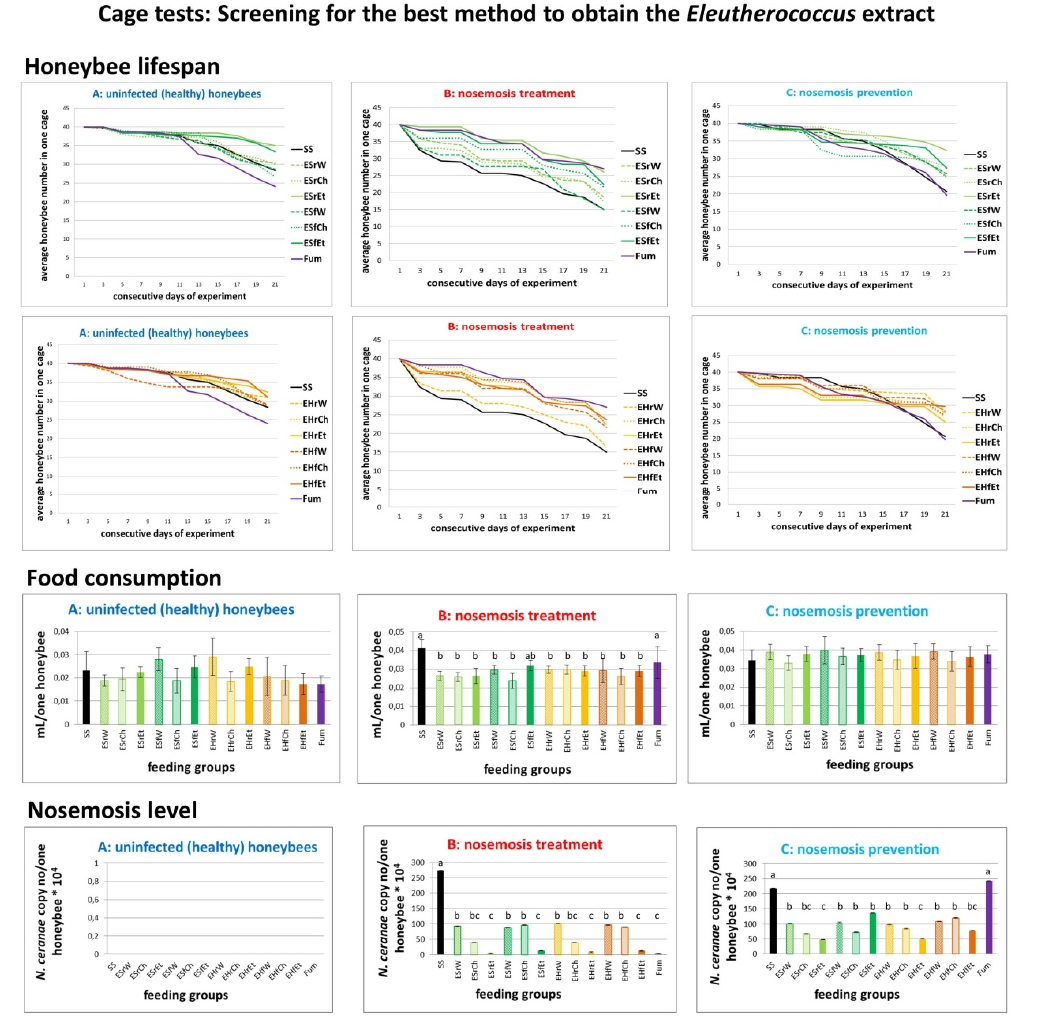
Figure 2. Results of cage tests: Screening for the best method of obtaining the Eleutherococcus extract. Data illustrated honeybee lifespan, food consumption and levels of nosemosis in all three variants of experiments conducted, i.e., ( A ) uninfected honeybees, ( B ) treatment of nosemosis and ( C ) prevention of nosemosis were compared. Lowercase letters (a,b,c) indicate significant differences between the group fed pure sucrose syrup without extracts (SS) and the groups fed with additions of extracts (at least p ≤ 0.05 for the honeybee lifespan, p ≤ 0.01 for food consumption and p ≤ 0.005 for level of nosemosis) (ANOVA, Tukey test). Error bars denote a confidence interval (CI). Laboratory extracts of E. senticosus (ES) and E . henryi (EH) were obtained using three different methods (water, W, chloroform, Ch, and ethanol, Et, extraction) from these plants’ roots and fruits (Table 2). 14 feeding groups (acronyms are defined in Supplementary Materials Table S2), i.e., (1) SS (control, pure sucrose syrup), (2) ESrW, (3) ESrCh, (4) ESrEt, (5) ESfW, (6) ESfCh, (7) ESfEt, (8) EHrW, (9) EHrCh, (10) EHrEt, (11) EHfW, (12) EHfCh, (13) EHfEt, (14) Fum (positive control in the treatment of nosemosis, fumagillin). All pure laboratory extracts were added in the concentration of 0.4 mg/mL to compare three different methods of obtaining extracts. 2.1.3. Results of Cage Tests: Screening for the Best Eleutherococcus Dose Laboratory E . senticosus ethanol root extract was added to the sucrose solution to the final concentrations of 0.05 mg/mL, 0.2 mg/mL, 0.4 mg/mL, 0.9 mg/mL and 1.5 mg/mL (Figure 3, acronyms are defined in Supplementary Materials Table S3). E . senticossus in 0.4 mg/mL concentration visibly